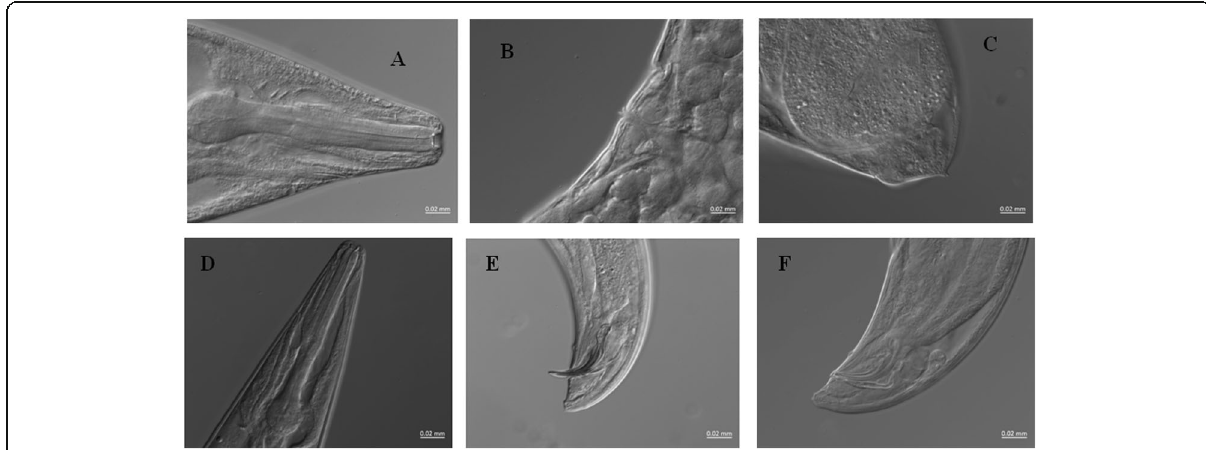
Fig. 1 LM photos of first generation female. a Anterior part with excretory pore. b Vulva with epiptygma. c Tail with mucro and first generation male. d Anterior part with excretory pore. e Spicule lateral view with mucro. f Gubernaculum lateral view